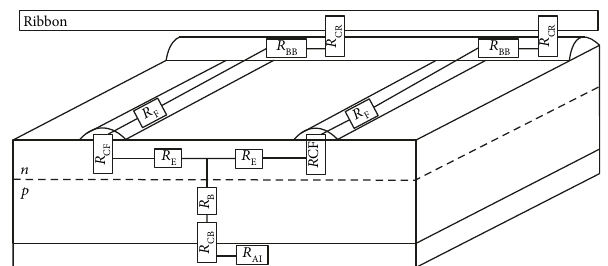
Figure 1: Schematic representation of the solar cell series resistivity.